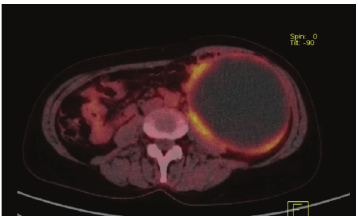
Figure 2: PET/CT scan of the abdomen (sagittal view) showing a cystic mass with peripheral uptake of 18-FDG.